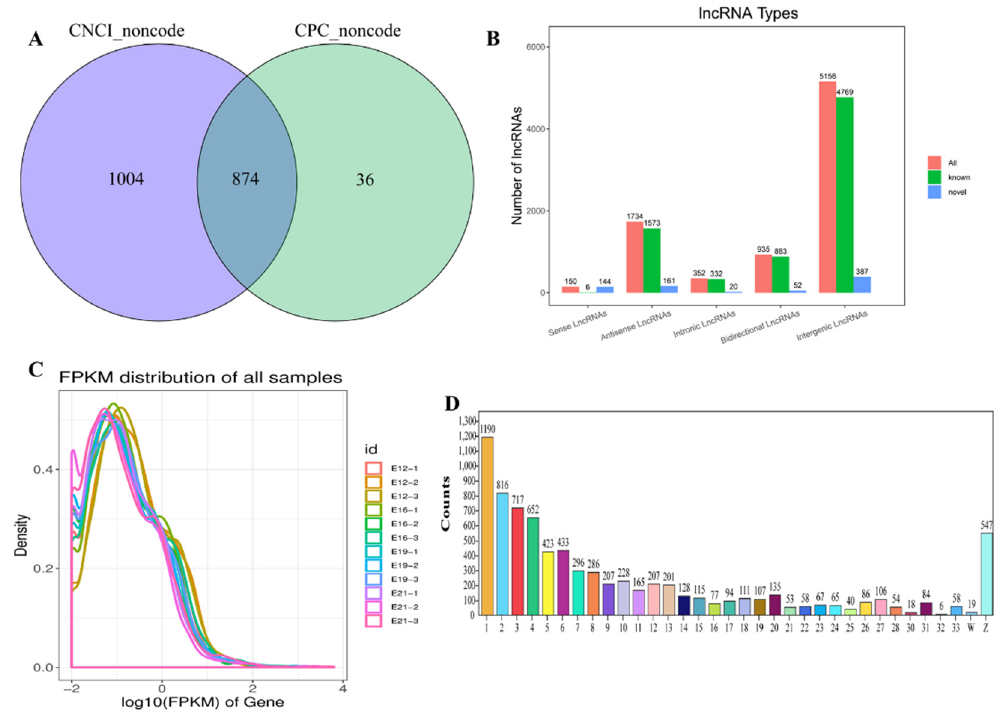
Figure 1. Overview of RNA sequencing in the muscle stages. ( A ) Venn diagram of CPC and CNCI (the prediction of novel lncRNAs). ( B ) The types of lncRNAs. Abscissa represents lncRNA types, and the ordinate represents lncRNA quantity, respectively; ( C ) The distribution of FPKM for lncRNAs; ( D ) the transcripts’ number distribution of chromosomes for lncRNAs. Abscissa represents chromosome type, and the ordinate represents lncRNA quantity, respectively.